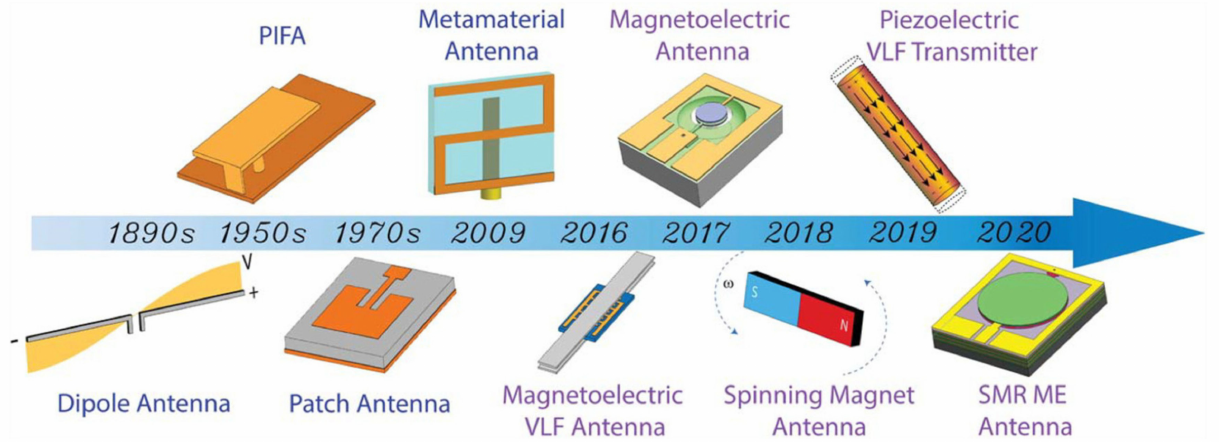
Figure 9. Development of compact antennas from the dipole antenna to the mechanical antenna and ME antenna. Reprinted with permission from ref. [42]. Copyright 2021 AIP